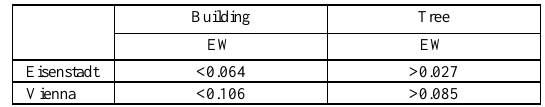
Table 5. Normalized EW thresholds for Eisenstadt and Vienna.